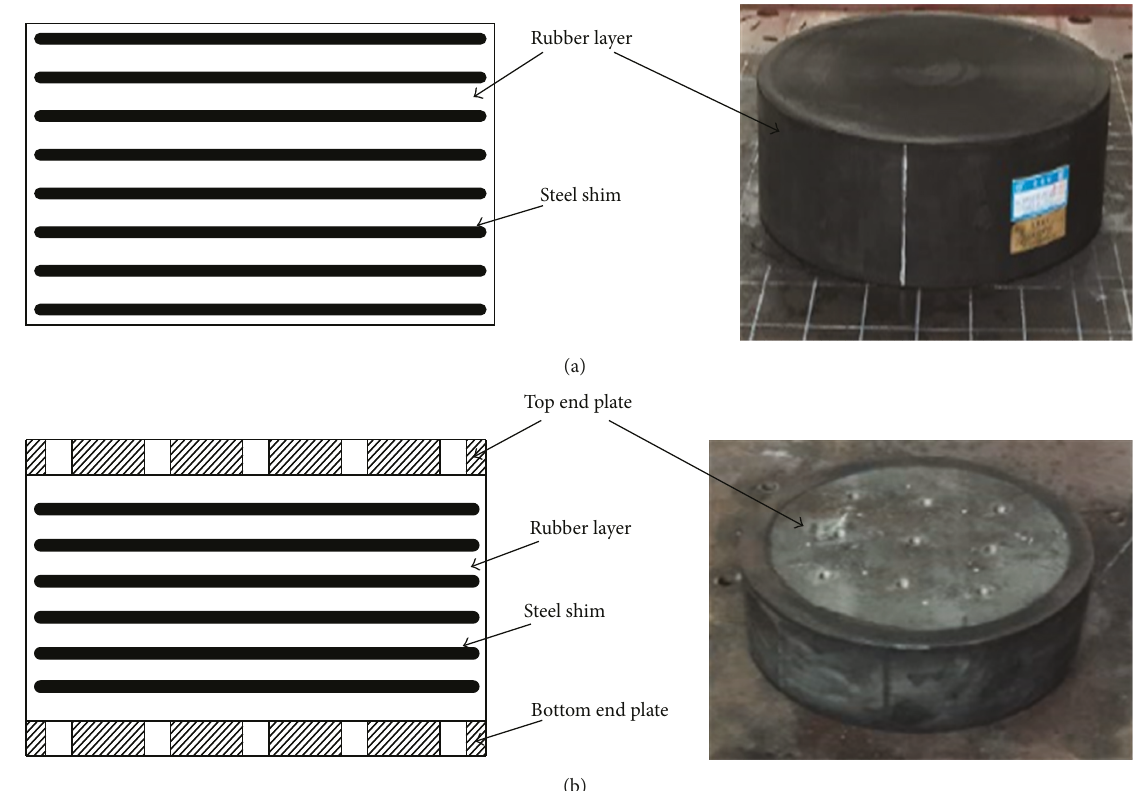
Figure 2: Sketch of testing specimens: (a) bearing type Y1/Y2; (b) bearing type Y3.